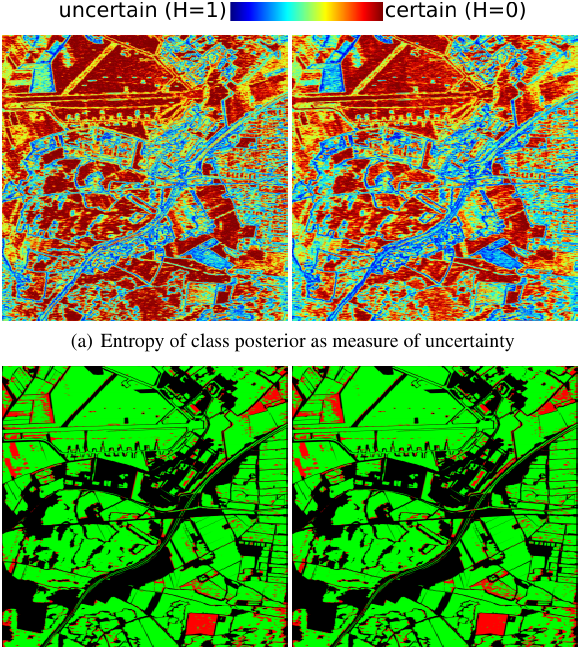
Figure 10. Correctness of the classification result for the initial (left) and final (right)